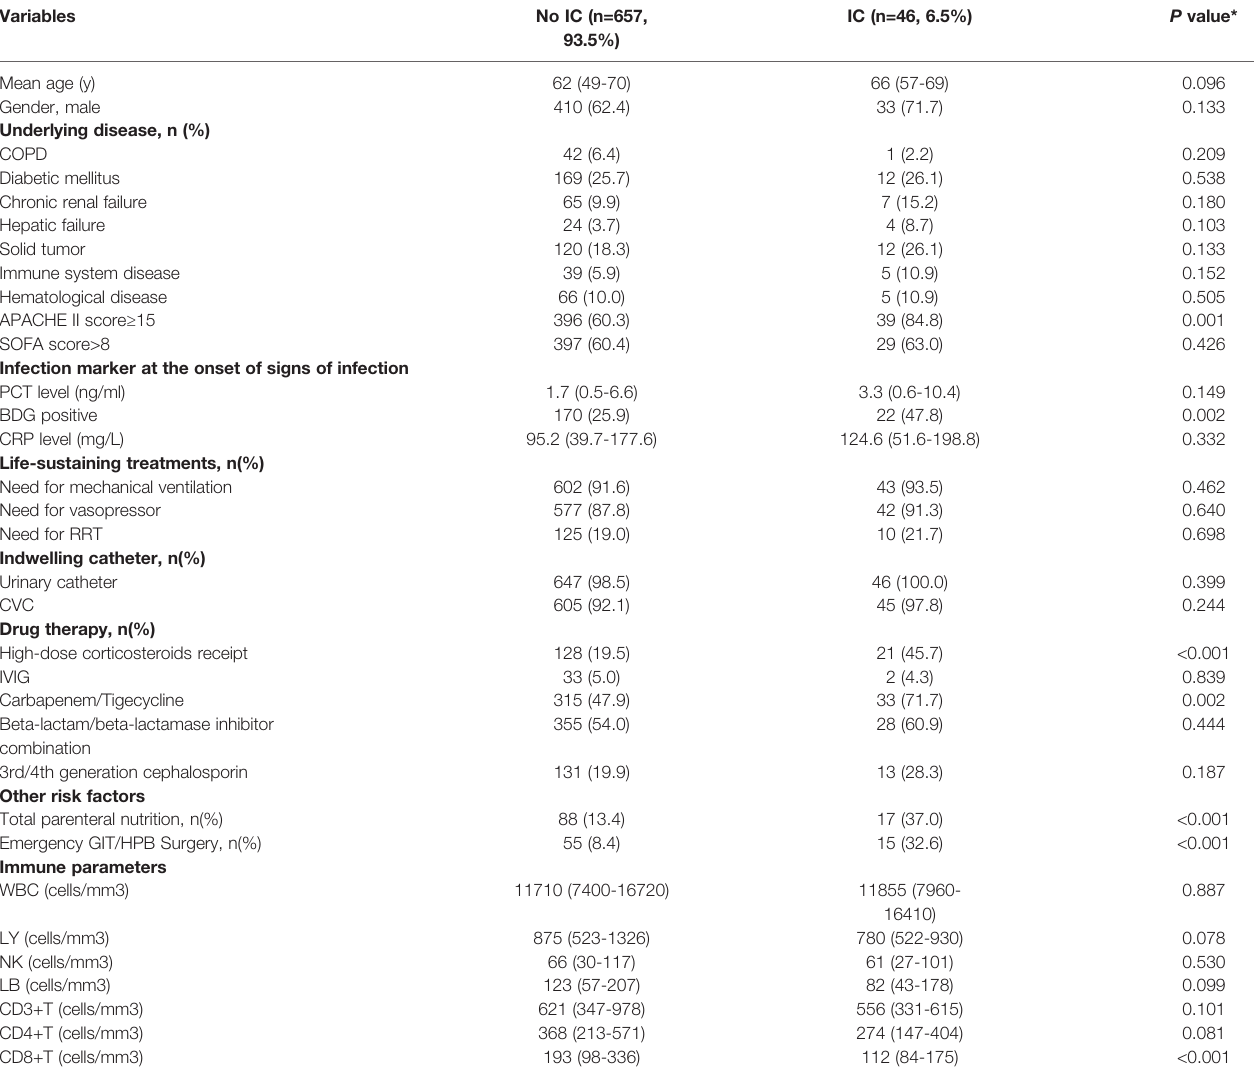
TABLE 1 | Demographic and clinical characteristics of the development cohorts at onset of infection according to IC diagnosis (N=703). Variables